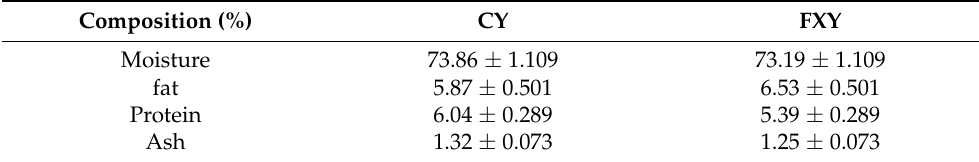
Table 1. Chemical composition of goat milk